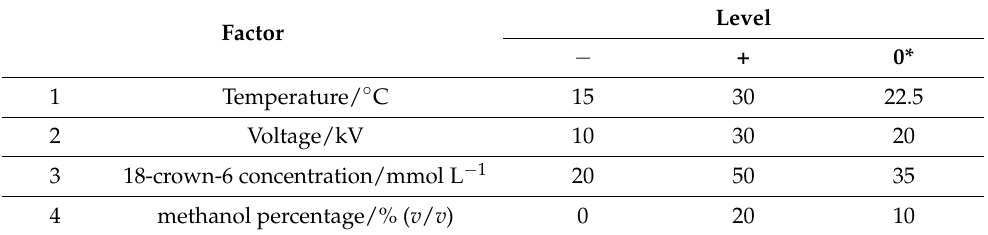
Table 1. Levels used for the implementation of DOE using four factors.